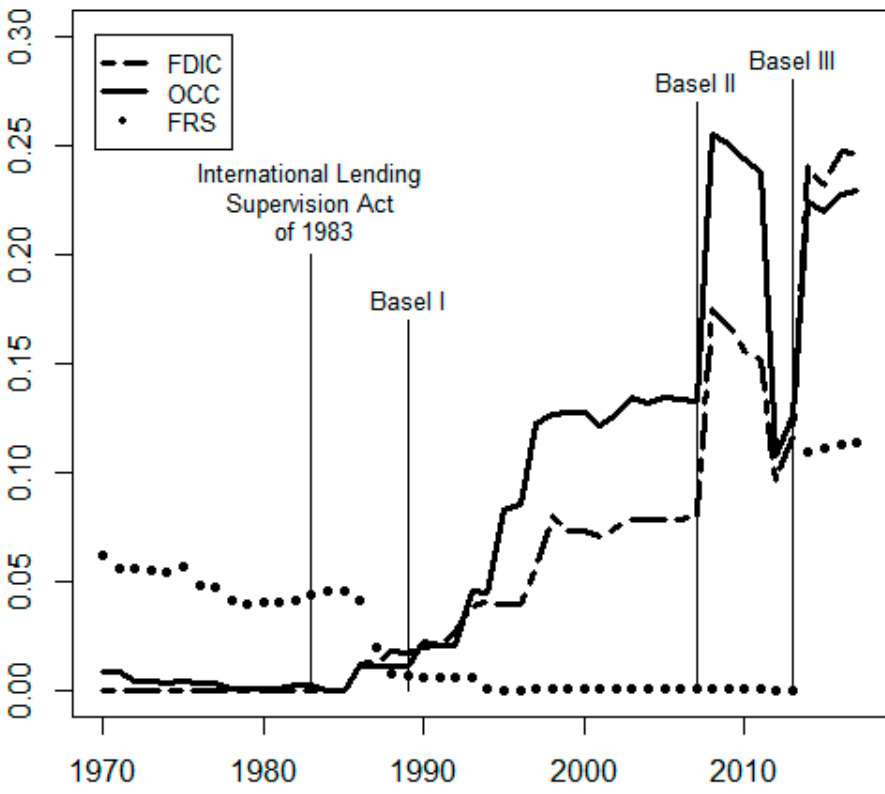
Figure 1. The Fraction of Regulatory Restrictions Arising from Bank Capital Requirements, 1970-2017.